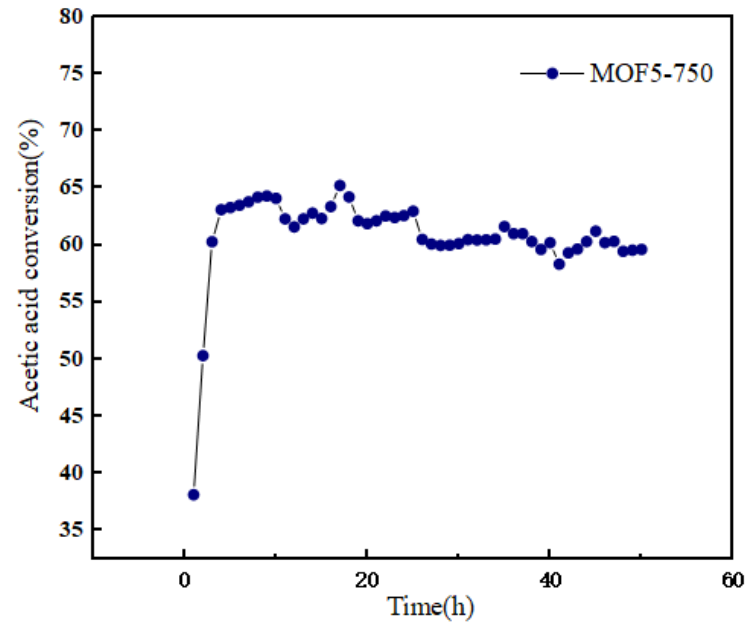
Figure 11. 50 h stability evaluation of MOF5-750 zinc-based catalyst.